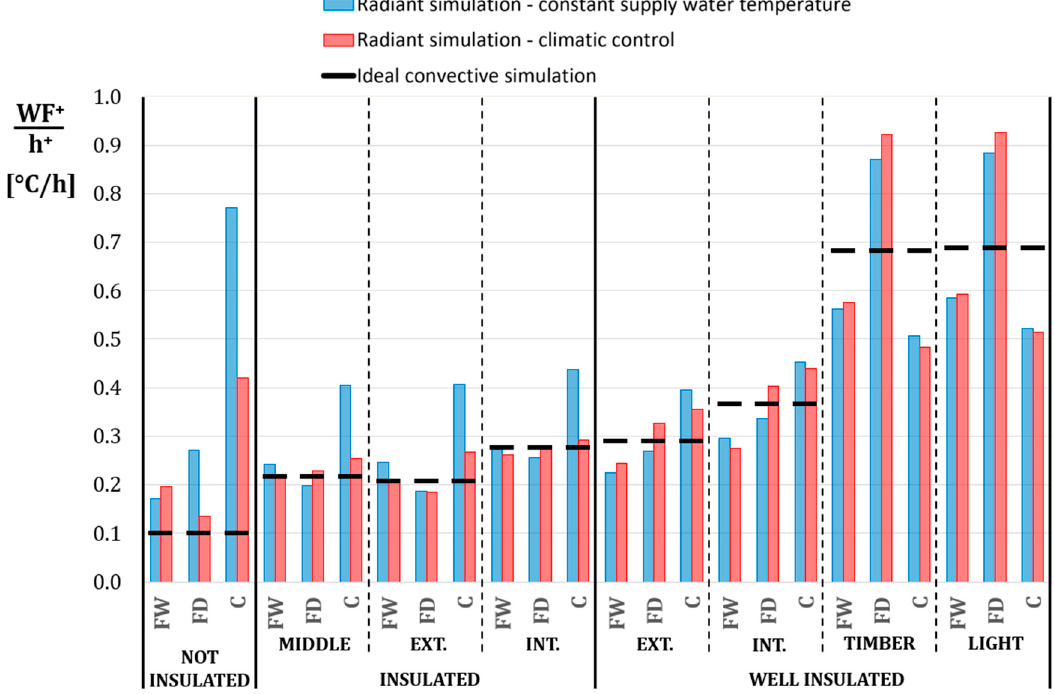
Figure 12. Mean value of the specific overtemperature in the radiant cases and in the equivalent ideal convective ones.